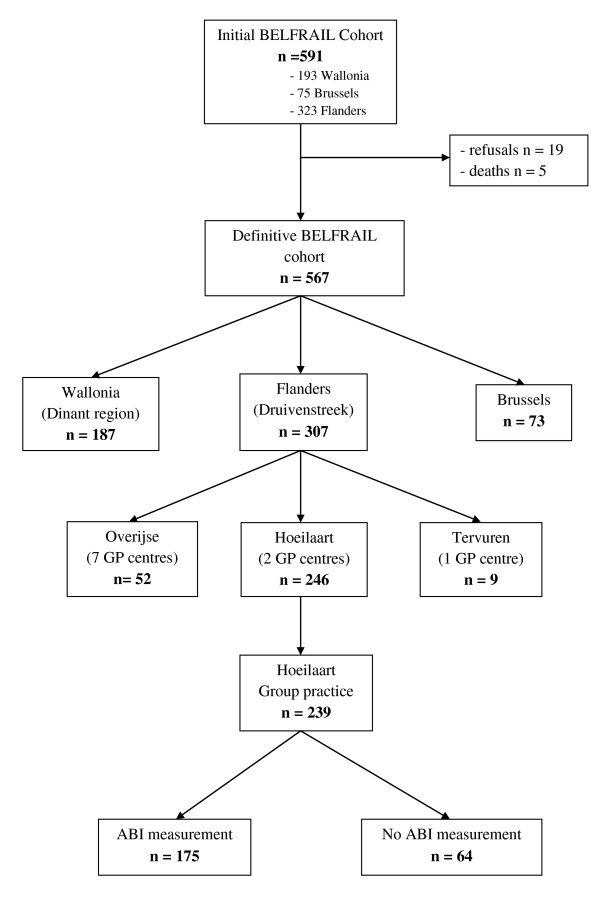
BELFRAIL study participants flow-chart.